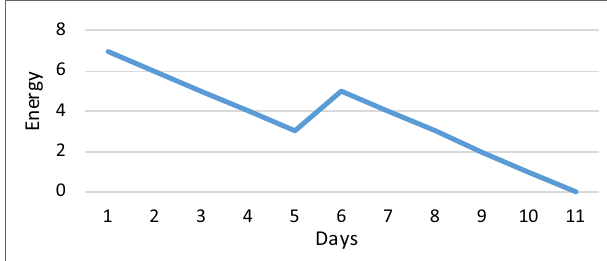
Days FigUre 2 | example of the energy consumption over time . It can be noticed that on the 5th day some food was delivered and thereby the vital energy increased.